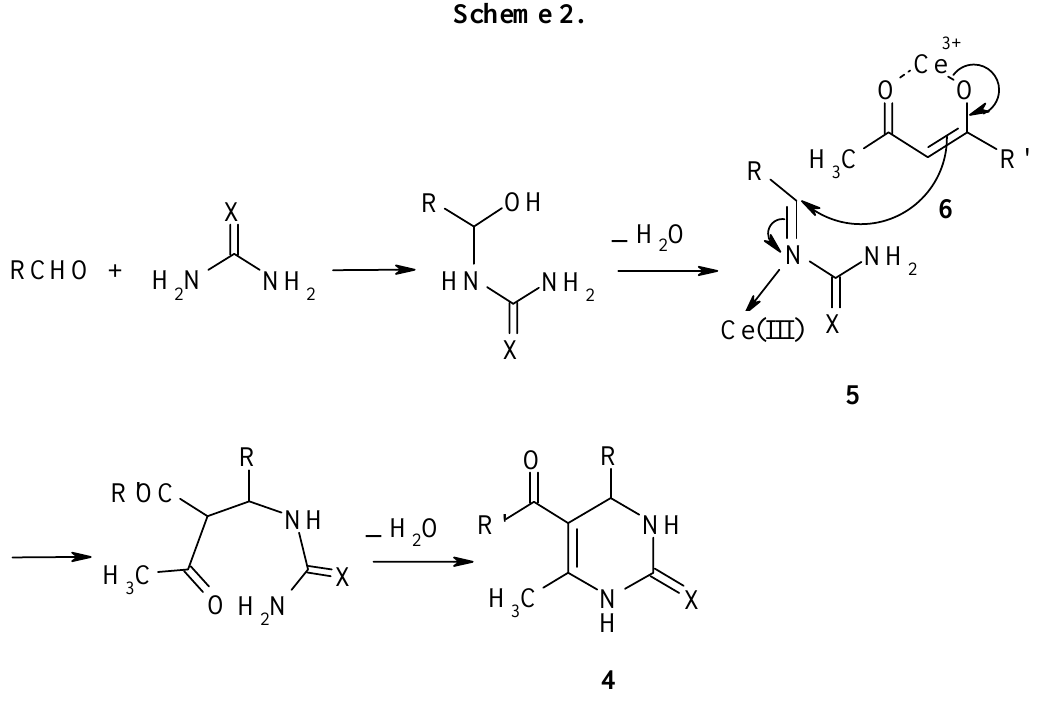
Table 1. Ce(NO ) ·6H O-Catalyzed Synthesis of Dihydropyrimidinones 3 3 2 and Dihydropyrimidinethiones under Solvent-Free Conditions a